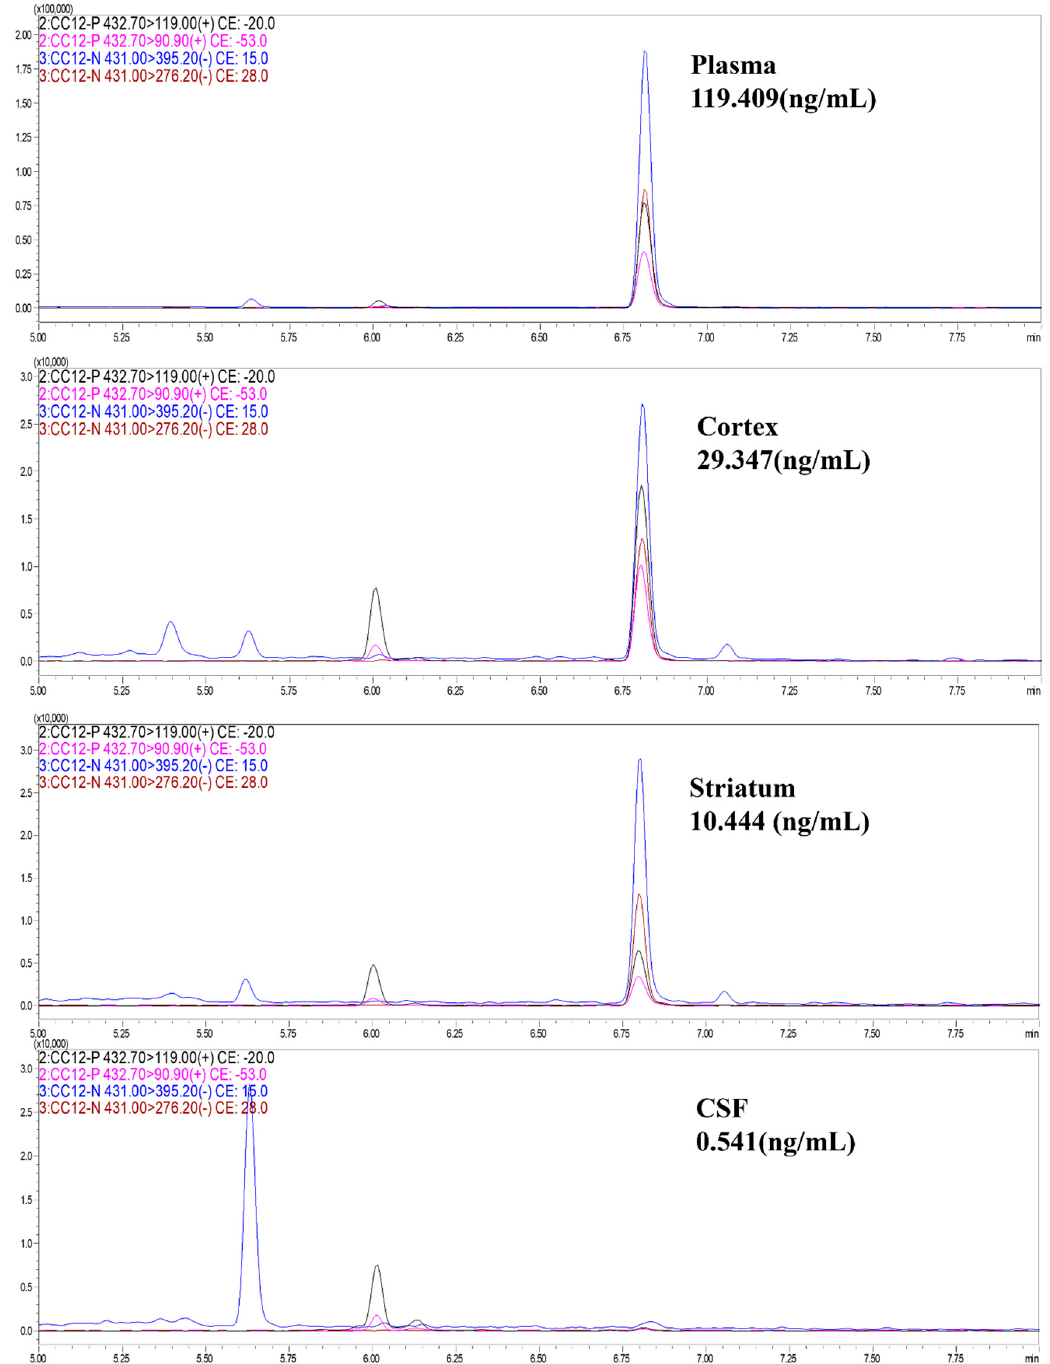
Figure 7. CC12 can cross the brain-blood barrier. HPLC/MS analysis results indicated that CC12 can be detected in plasma, cortex, striatum, and CSF from mice that received 5 mg/kg CC12 for 28 days.